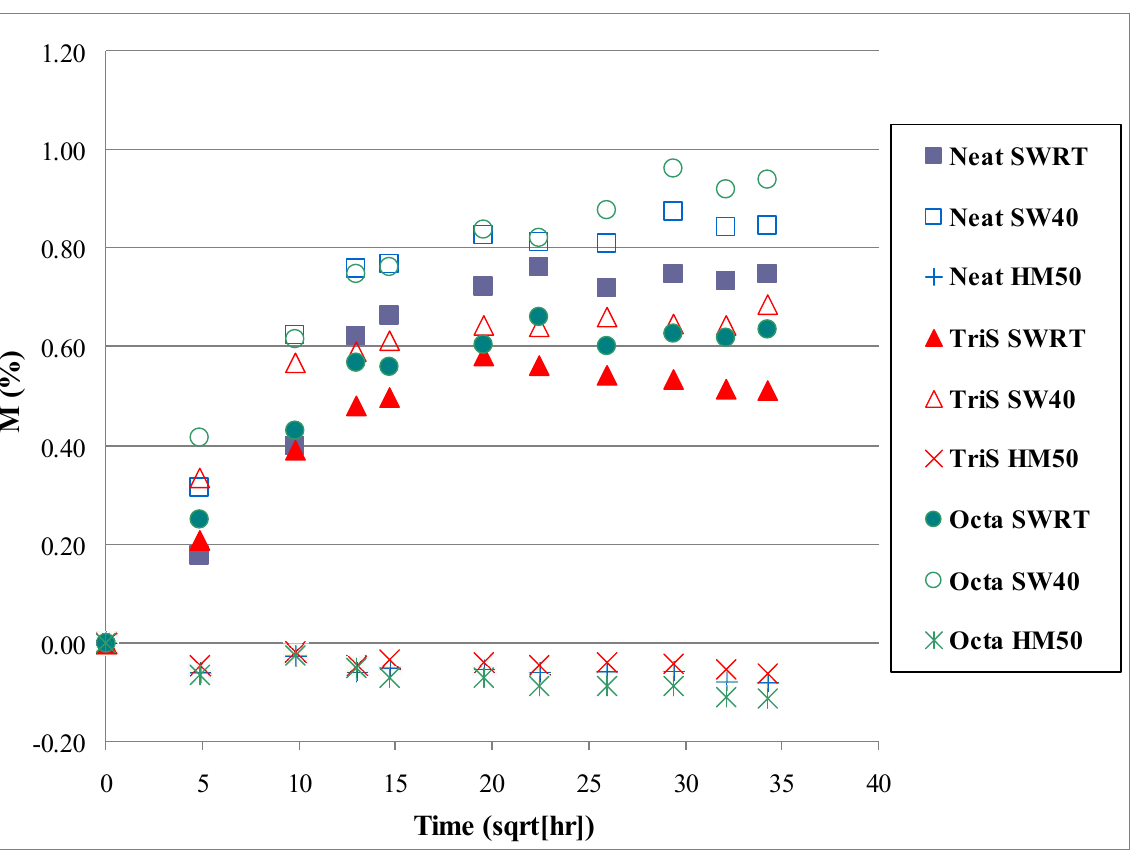
Figure 4. Percentage of weight change in saltwater 40 °C.